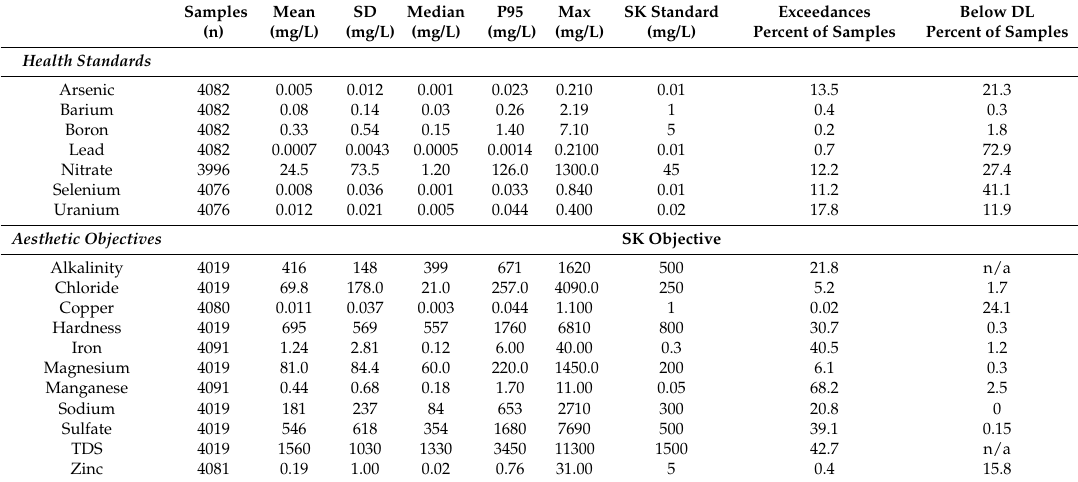
Table 2. Descriptive statistics for individual samples in private water supplies in Saskatchewan during 1996–2011, along with the Saskatchewan standards and objectives, percent of samples exceeding the respective standard or objective, and percent of samples below detection limit for the water parameters included in the analysis.